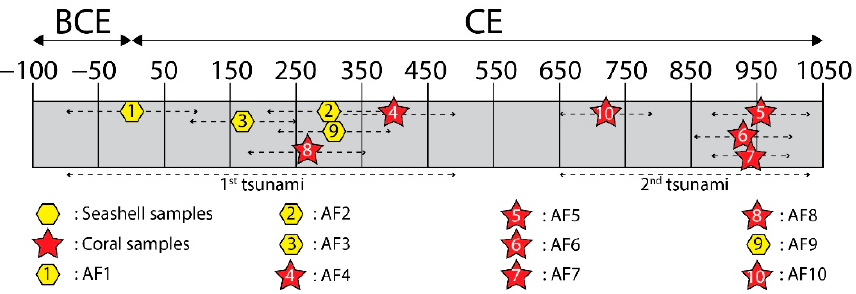
Figure 10. Dating results for coral and seashell samples in the abandoned fishponds in Kiantar Village.